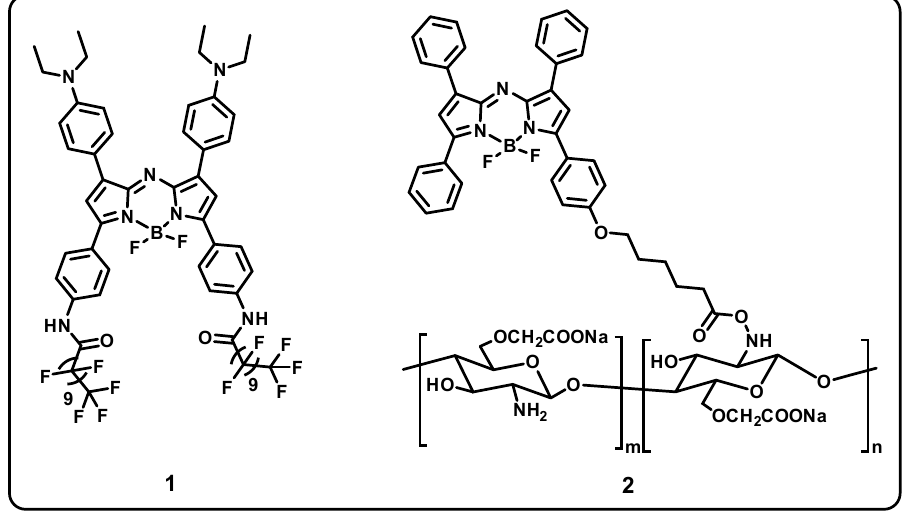
Figure 7. Structure of fluorinated aza-BODIPY ( 1 ) and BODIPY-grafted water-soluble chitosan ( 2 ). Li et al. [98] studied BODIPY-grafted water-soluble chitosan-based nanoshells for drug release ( 2 ). The loaded drug methotrexate into the nanoshells resulted in chemotherapy, photothermal treatment, photodynamic therapy, and imaging in one platform for combi- natorial treatment in HeLa cells (Figure 7). The nanoshells can act as drug transporters, increasing solubility, decreasing toxicity, and improving the utility of combinatorial PTT and PDT. The reduced dosage of chitosan-based nanoparticles (IC 50 = 34.5 g/mL) is lower than the corresponding drug MTX (IC 50 = 56.9 g/mL), indicating good biocompatibility and safety of chitosan-based BODIPY nanoshells as carrier materials. Photothermal tem- perature and MTT tests demonstrate that NPs generate ROS and have high photothermal conversion efficiency (38.3%) when exposed to light. Meng et al. [99] introduced pillar- layered metal–organic frameworks based on BODIPY for chemotherapy and PDT ( 3 ). A unique two-fold interpenetration pillar-layered MOF material was successfully synthesized employing the BODIPY-derivate bipyridine as a linker and photosensitizer, to act as a drug carrier and photodynamic agent at the same time (Figure 8). Upon 660 nm light irradiation, the system could produce singlet oxygen, while the drug doxorubicin could be loaded for chemotherapy. The system had a high drug loading efficiency of 49.7%, regulated drug release, and excellent biocompatibility. In Hela cells, the cellular uptake was evaluated at 1, 4, and 8 h, and high amounts of 1 O 2 were produced during light